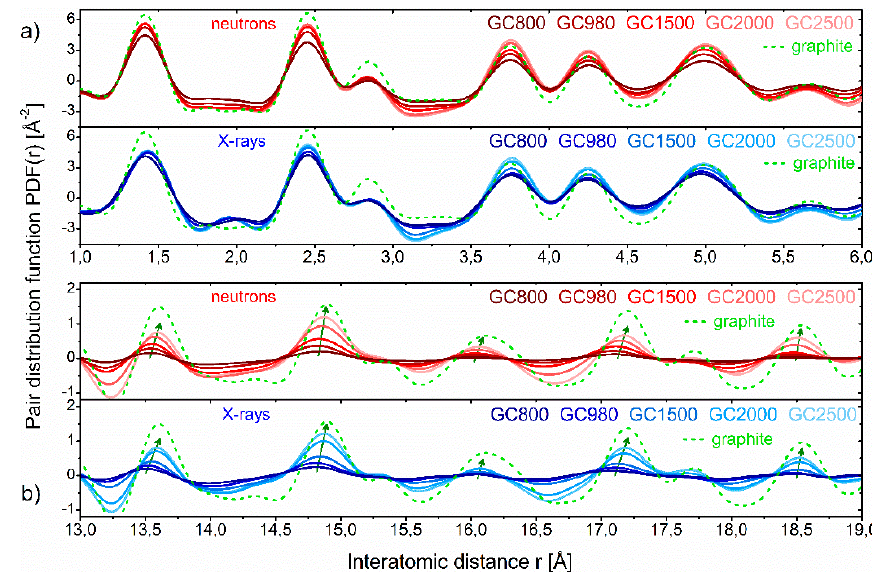
Figure 24. ( a ) Comparison of the experimental pair distribution functions determined from ND and XRD measurements for glassy carbons pyrolysed at temperatures in the the range 800–2500 °C with the function calculated for a single unstrained graphite layer in the short-range order and ( b ) in the intermediate-range order. Reproduced with permission from Jurkiewicz et al. [26]. Copyright